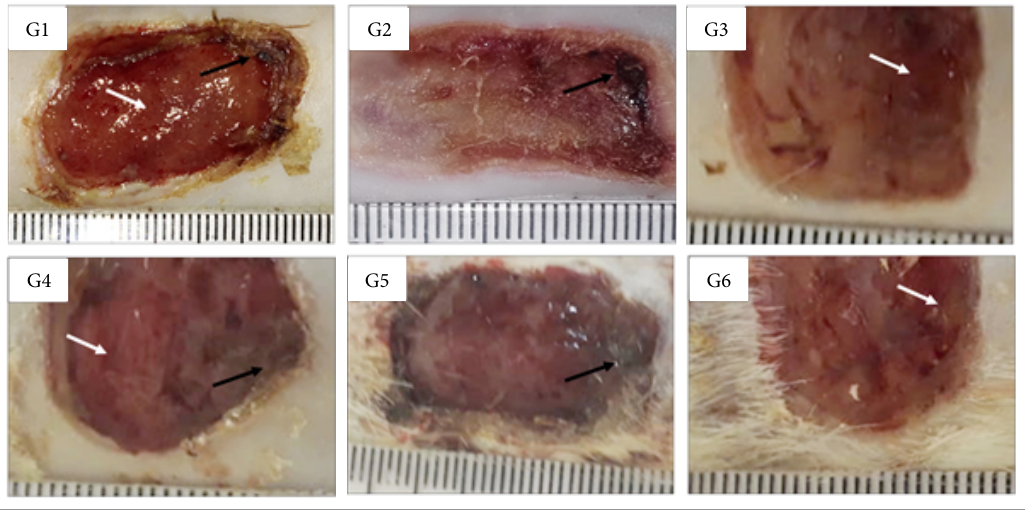
Figure 1 - Macroscopic aspects of partial thickness burn wounds experimentally induced in Wistar rats seven days after the injury induction. Scale in